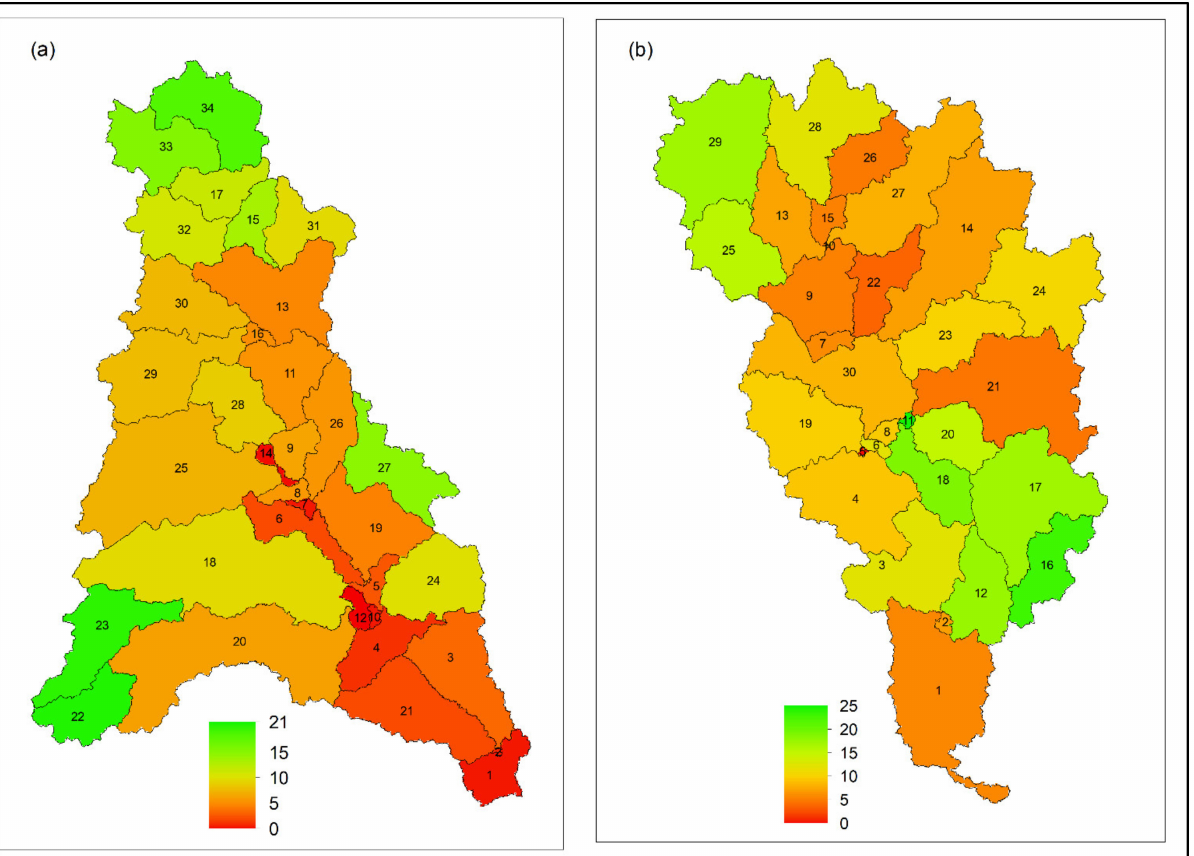
Figure 13. Spatial distribution of average annual sediment yield (t/ha/yr) ( a ) over the Nagavali river basin ( b ) over the Vamsadhara river basin for the period of 13 years